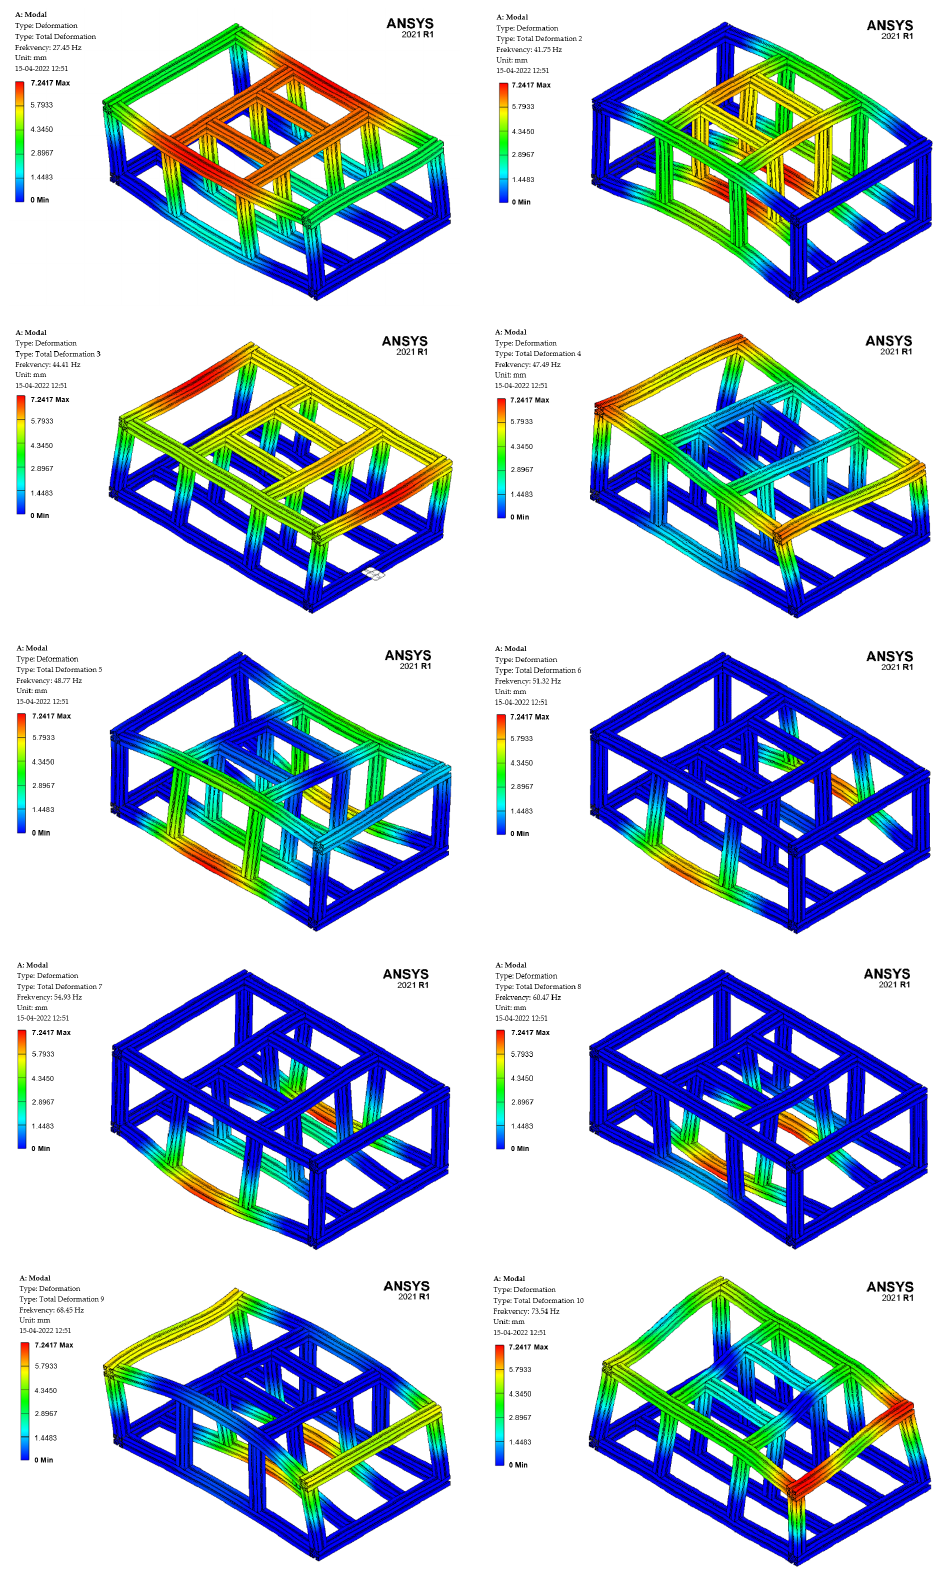
Figure 4. Custom shapes of frame oscillations.